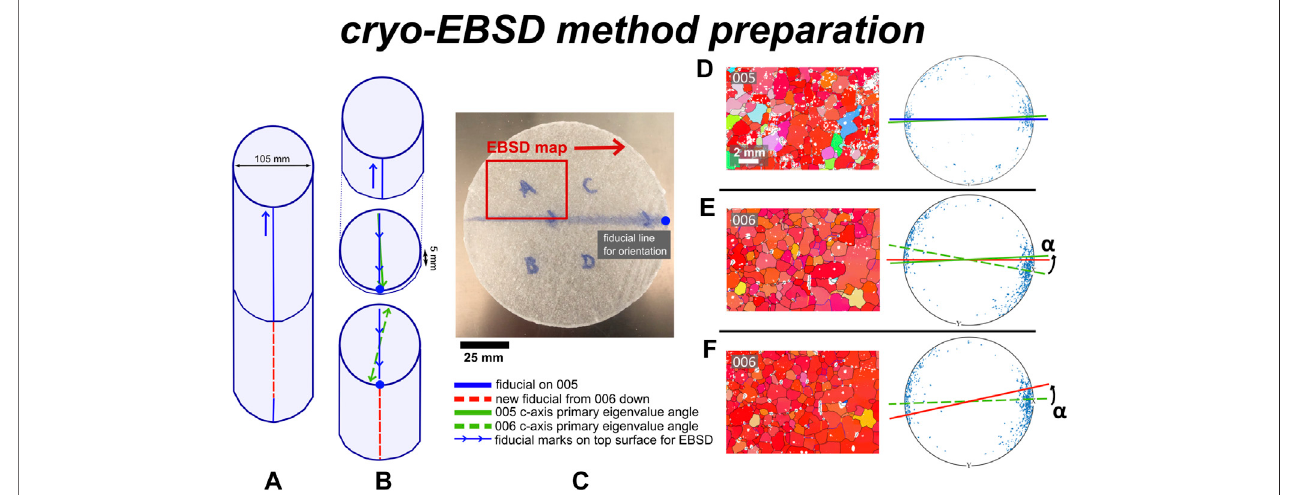
FIGURE4| Amethodforreinstatingorientationeithersideofa fi duciallinebreak. (A) Adif fi cult fi tisrecordedduringprocessing.Coreslicesarecuteithersideofthe break. (B) The top surfaces of each slice are marked to show the direction of the fi ducial line. (C) A small section of the slice is used for cryo-EBSD analysis. (D) The difference between the c -axis alignmentrelative tothe fi ducial linereferencefor thesample above thebreak and (E) thesamplebelow thebreakde fi nethe rotationangle α . (F) Cryo-EBSD data for the lower sample is rotated by angle α to restore azimuthal orientation.